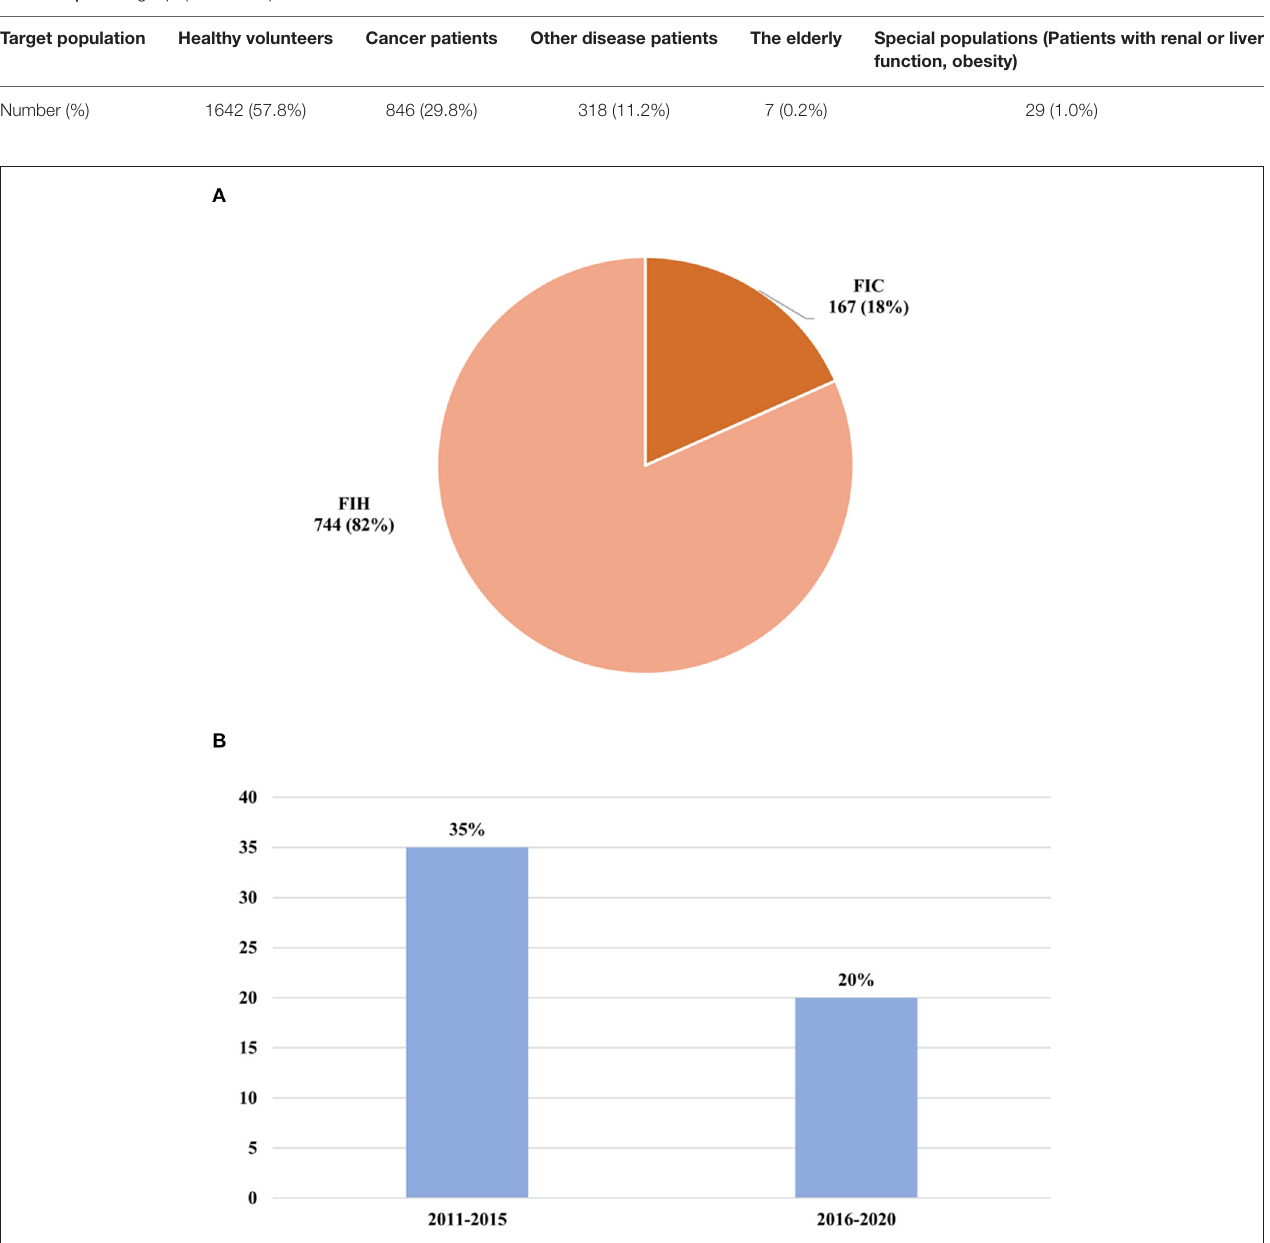
TABLE 1 | The target population of phase I clinical trials.